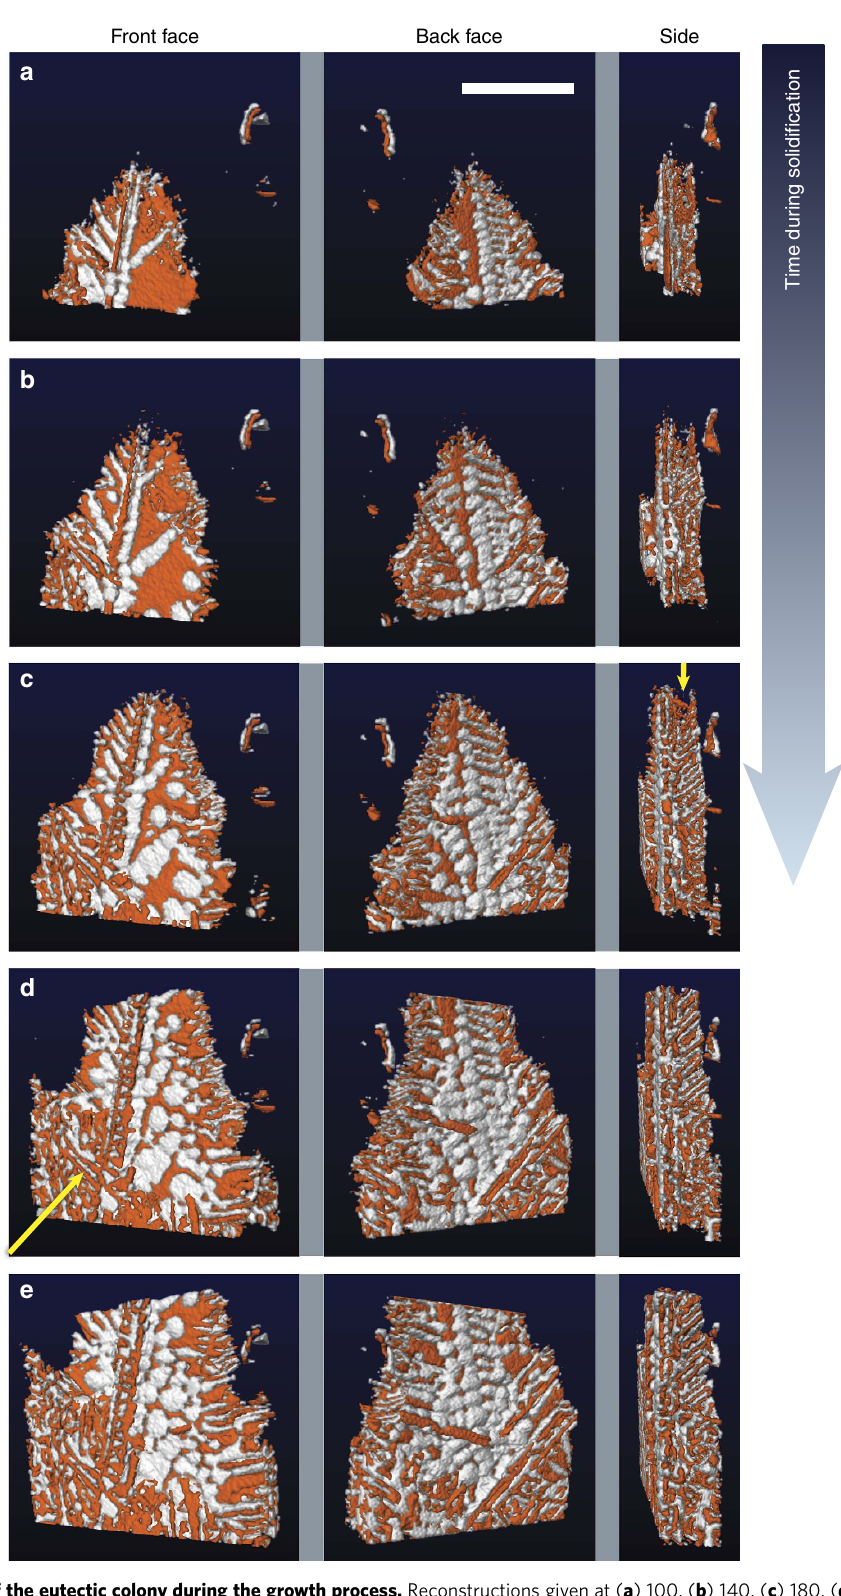
Figure 3 | Morphology of the eutectic colony during the growth process. Reconstructions given at ( a ) 100, ( b ) 140, ( c ) 180, ( d ) 220 and ( e ) 260s after the start of solidification. Shown are three views per time-step, corresponding to the front (0 (cid:2) ), back (180 (cid:2) ) and side (90 (cid:2) ) of the eutectic colony. The arrow in the side view of c points to the tips of the Ge plates that lead the solidification event; the arrow in the front view of d points to another eutectic colony that impinges upon the one of interest. When viewed from either the front or the back, the interfacial morphology is markedly different from that predicted by Fisher and Kurz 1 : bulbous-like domains of Al envelope the surfaces of Ge as solidification proceeds. Scale bar, 100 m